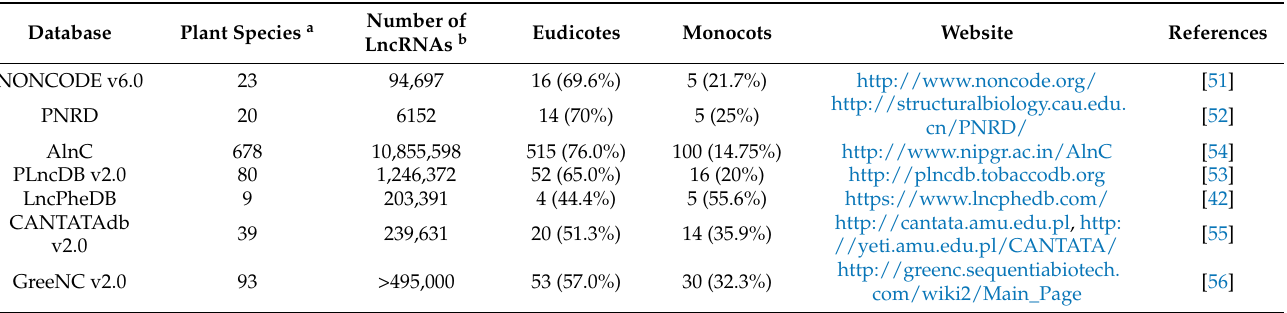
Table 1. Statistics of lncRNAs in plant databases.